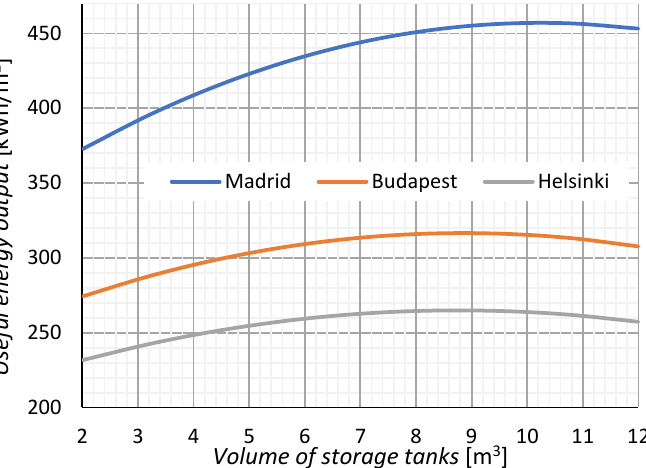
Figure 10. Dependence of the volume of heat storage tanks on an annual useful energy output.